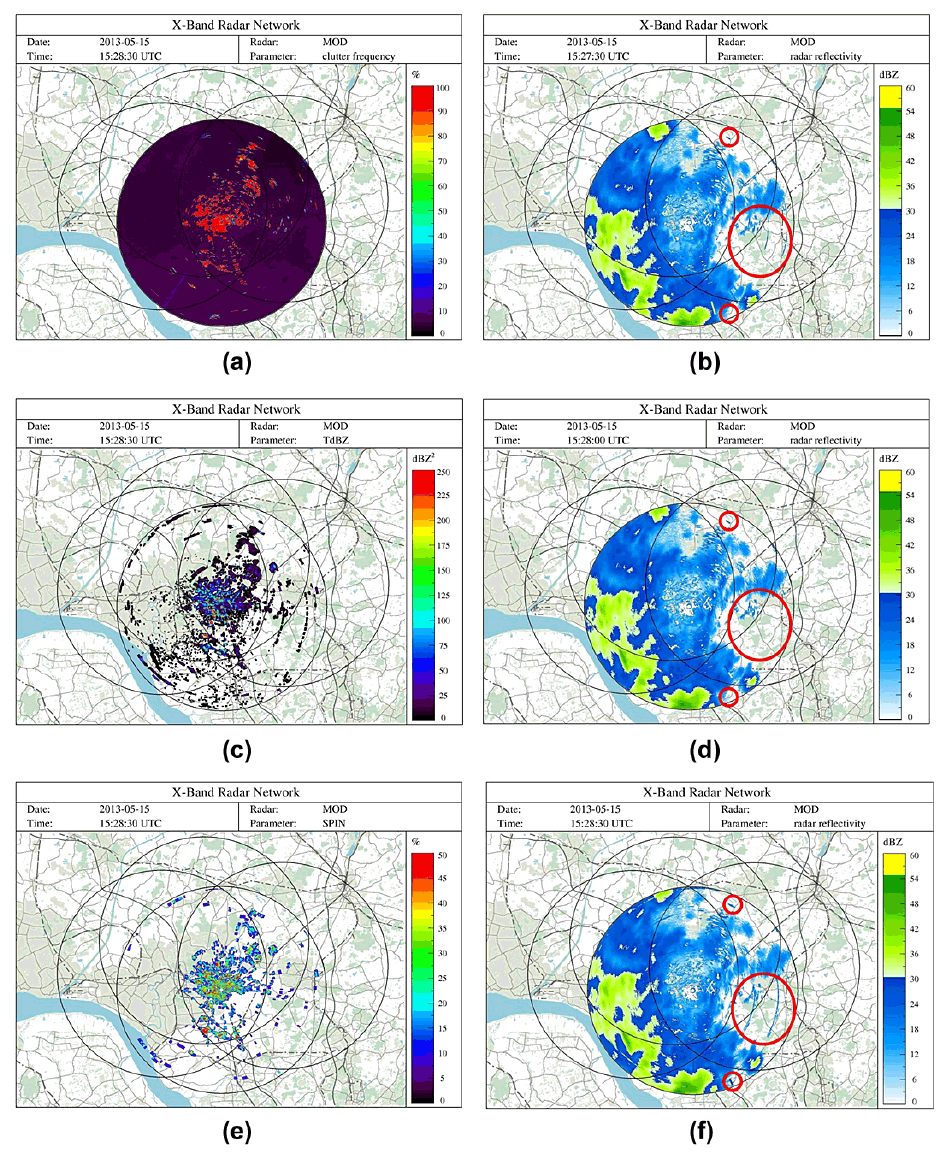
Figure 5. Clutter detection for radar MOD for 15 May 2013, 15:28:30UTC: (a) static clutter map, (b) TDBZ field, (c) SPIN field. Clutter detection using previous PPIs: (d) dBZ field for 15:27:30UTC, (e) dBZ field for 15:28:00UTC, (f) dBZ field for